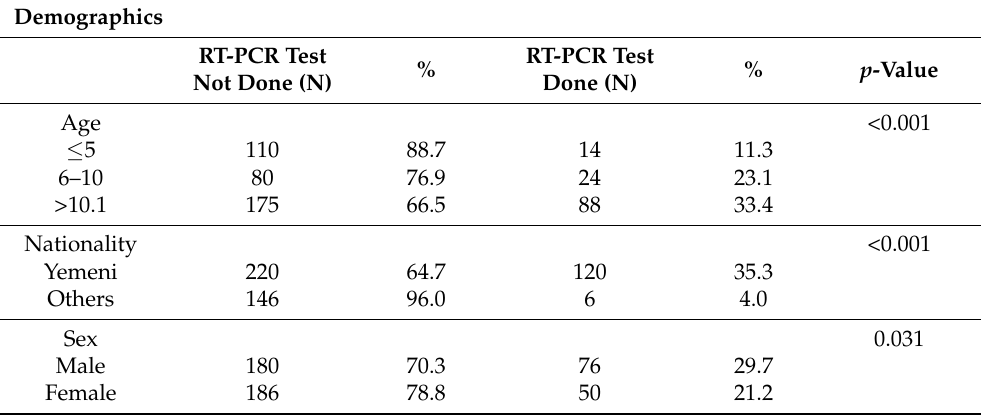
Table 5. RT-PCR Testing among Children of Different Demographic